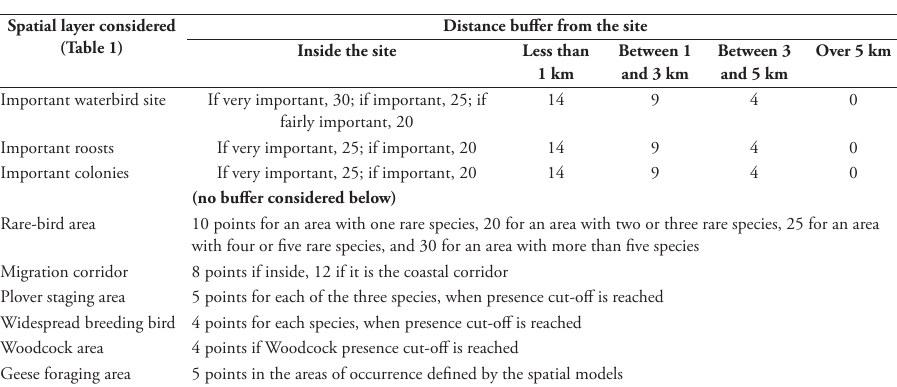
Table 2. Priority scoring system for the spatial units in the final